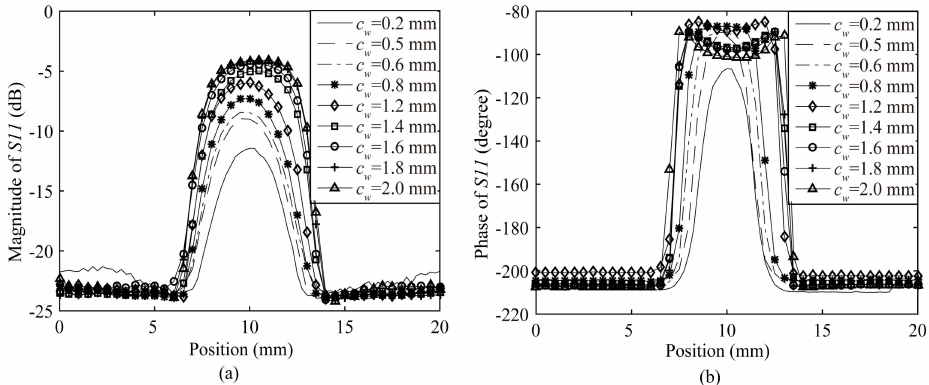
Figure 14. ( a ) The magnitude variations of the reflection coe ffi cient for the probe scanning the cracks of di ff erent widths; ( b ) The phase variations of the reflection coe ffi cient for the probe scanning the cracks of di ff erent